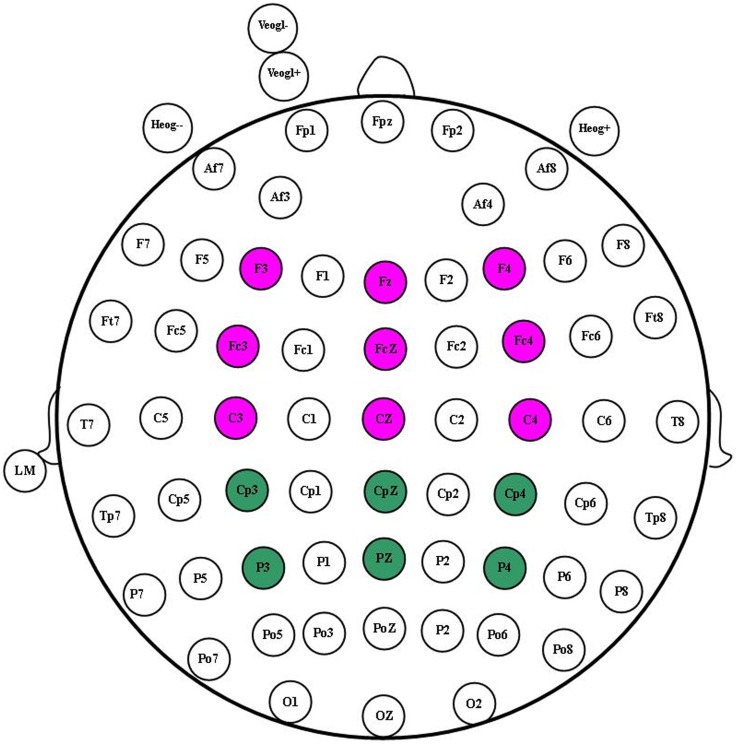
Electrode groups.